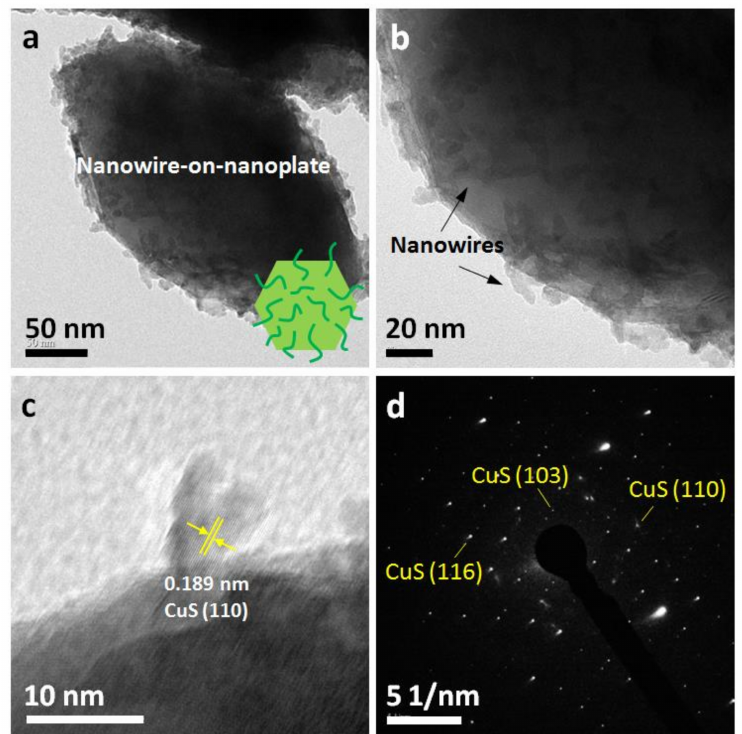
Figure 3. Transmission electron microscope (TEM) images ( a – c ) and corresponding selected area of the electron diffraction (SAED) pattern ( d ) of the as-obtained CuS.